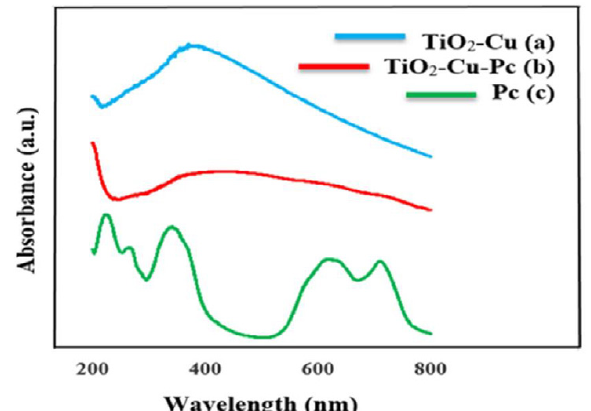
Fig. 6. The UV-visible spectroscopy data of: (a) Cu- TiO Figure 6. The UV-visible spectroscopy data of: (a) Cu- TiO 2 , (b) Pc-Cu- TiO 2 H-NC, and (c)